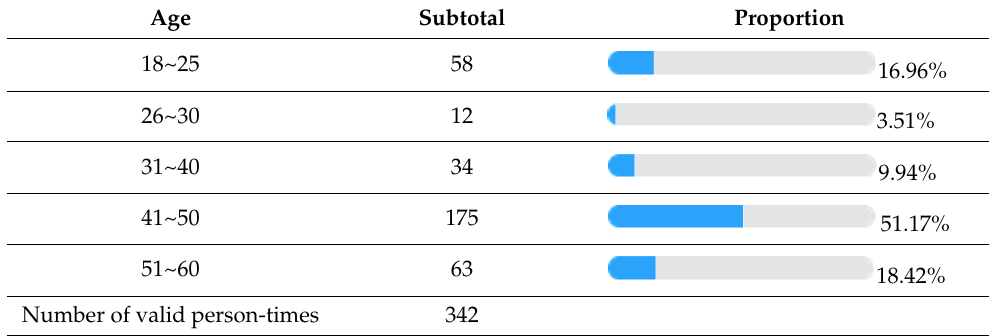
Table 2. The proportional distribution of respondent age.